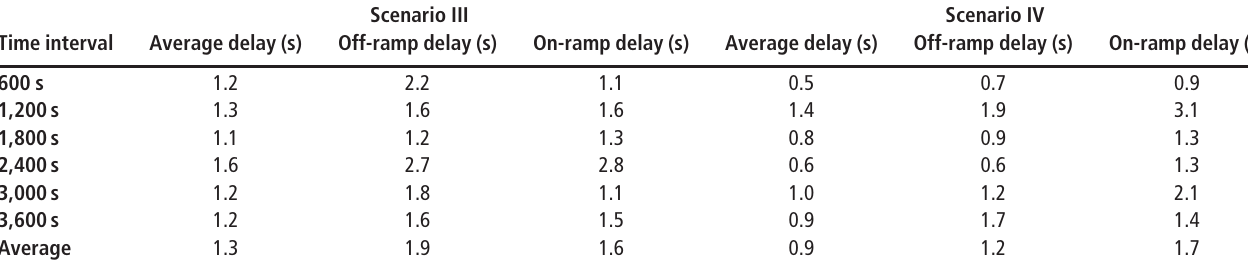
Table 2 Delay output of guiding lane changes in advance and change lane separation in the weaving area Time